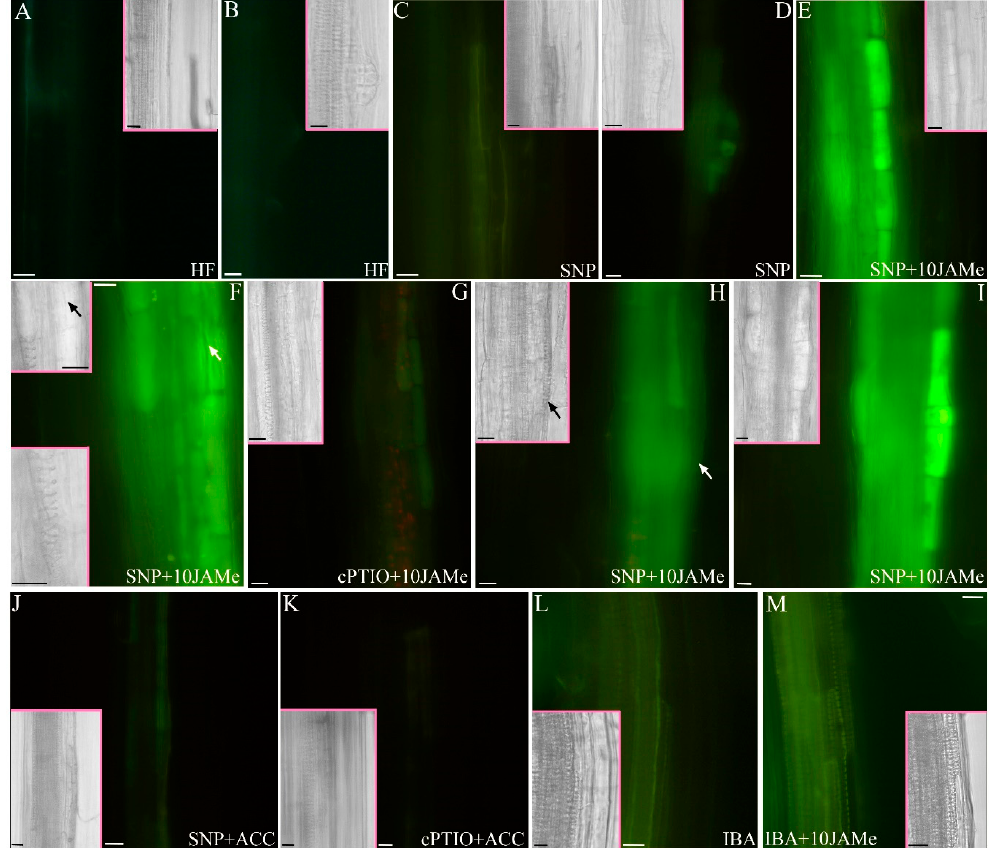
Figure 7. Analysis of NO epifluorescence signal, due to diaminofluorescein-FM diacetate (DAF-FMDA) treatment, in the basal hypocotyl of Col-0 (wt) seedlings dark-grown for 22 DAS. ( A ) Absence of epifluorescence signal in the pericycle periclinal derivatives occasionally formed in hormone-free (HF) condition. ( B ) Absence of epifluorescence signal in an adventitious root primordium derived from anticlinal pericycle divisions in HF condition. ( C,D ) Weak signal in correspondence of cells derived from periclinal (C) or anticlinal (D) divisions of the pericycle in seedlings treated with 50 μ M sodium nitroprusside (SNP). ( E , F ) Strong NO signal in the pericycle cells ( E ), and their first periclinal derivatives ( F ; arrow in the inset) in 50 μ M SNP + 10 μ M JAMe (SNP + 10JAMe)–treated seedlings.